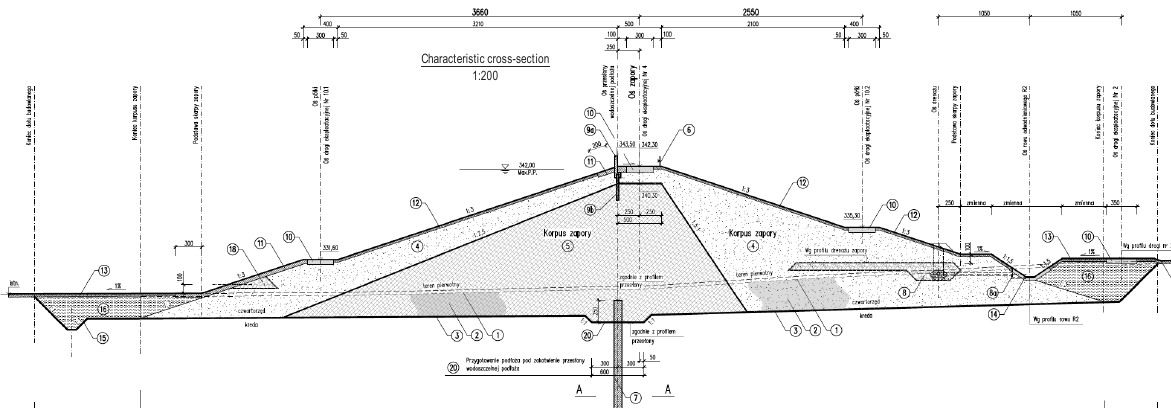
Figure 1: Characteristic cross-section of the dam (Sweco Consulting Sp. z o.o, 2019).